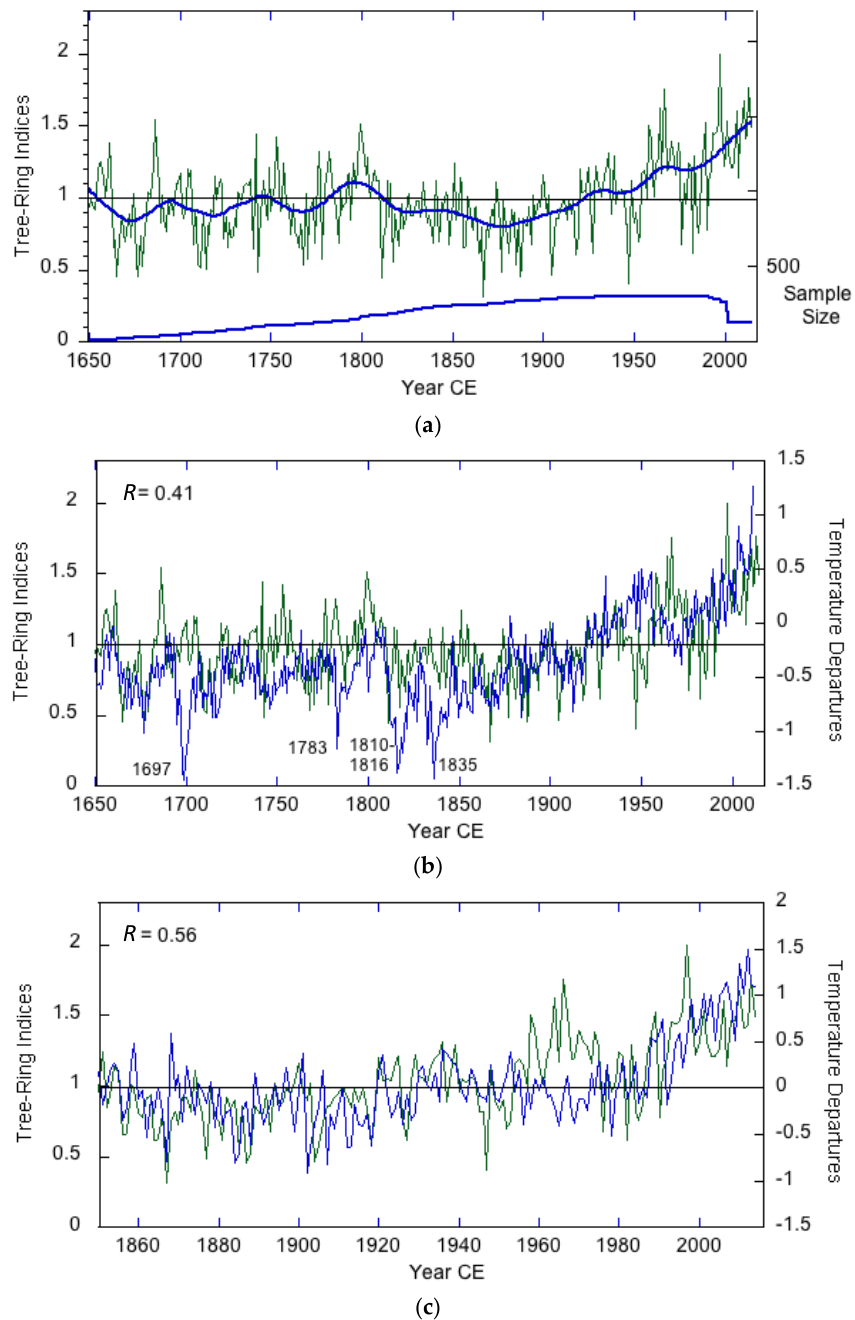
Figure 5. ( a ) Larch composite chronology (green, blue thick line shows values smoothed with a 6% weighted curve with Kaleidagraph) standardized using signal free regional curve standardization (RCS) and changing sample size over time (lower blue curve); ( b ) Larch composite chronology (green) compared with NTREND series (blue), which is composed of 54 Northern Hemispheric tree ring chronologies [20]. The correlation of larch with NTREND is 0.41 for 1670–2014. Major NH volcanic events are labeled on the NH record and note that the NH series deviates from the Kamchatka series; ( c ) Comparison of the larch ring ‐ width series (green) with the Northern Hemisphere meteorological summer temperatures [20]. The two NH series are coherent with the larch ring ‐ width series with respect to the low frequency variability. The records do diverge in the decades of the 1950s and 1960s, possibly due to wide scale disturbance and logging at the varied sites and a growth release during this